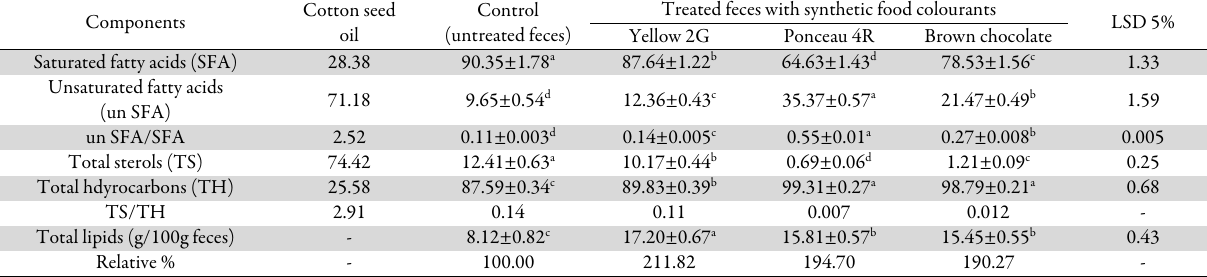
Table 1. Effect of synthetic food colourants on total lipids, saturated, unsaturated fatty acids, sterols and hydrocarbons of rat feces Components